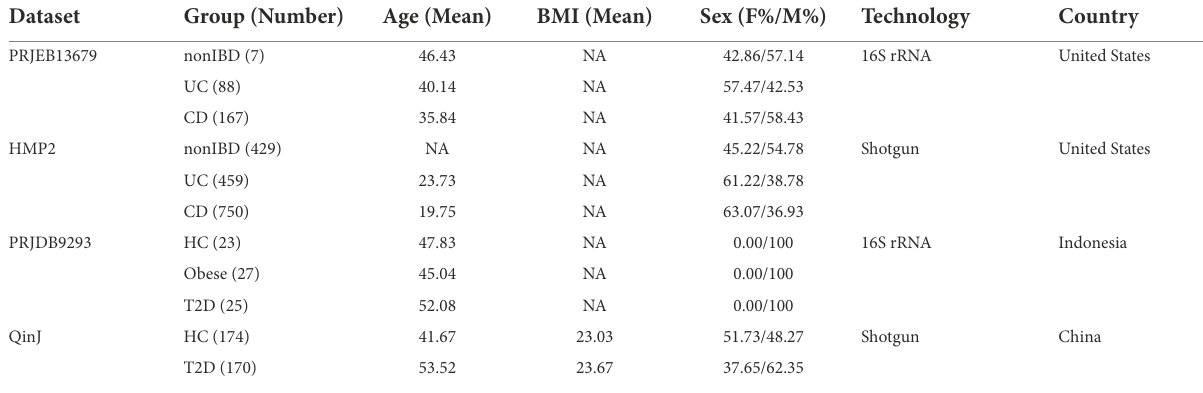
TABLE 2 The demographic information of metabolic diseases datasets.